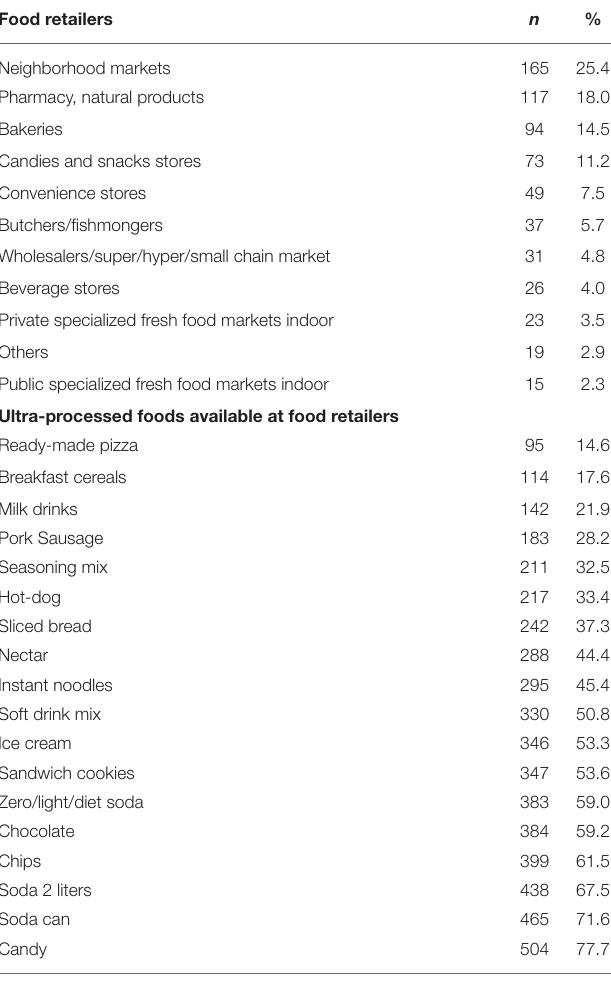
TABLE 1 | Distribution ( n and %) of food retailers and ultra-processed foods available at food retailers. Food